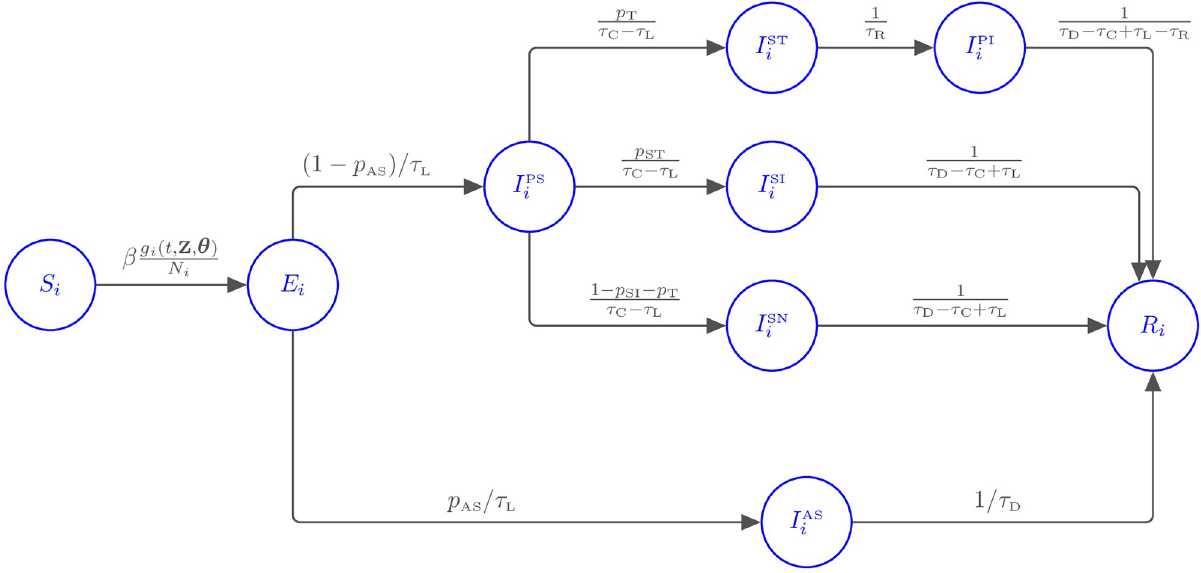
Fig 3. Diagram representing interactions in the age-structured SEIR system of ODEs with rate of movement between classes indicated. The compartments are susceptible ( S ), exposed ( E ), infected and removed ( R ), asymptomatic ( I AS ), pre-symptomatic ( I PS ), symptomatic and self-isolating without testing ( I SI ), symptomatic and awaiting test results ( I ST ), symptomatic and isolating after receiving positive test results ( I PI ) and symptomatic but not tested or isolating ( I SN ). A full description is given in Eq (1).